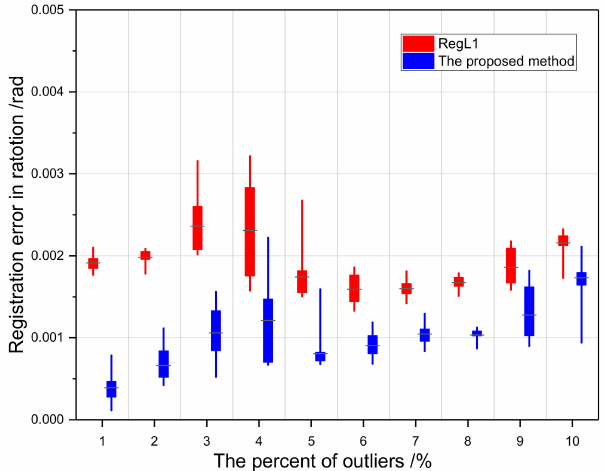
Figure 8. The relation between registration error and the percentage of